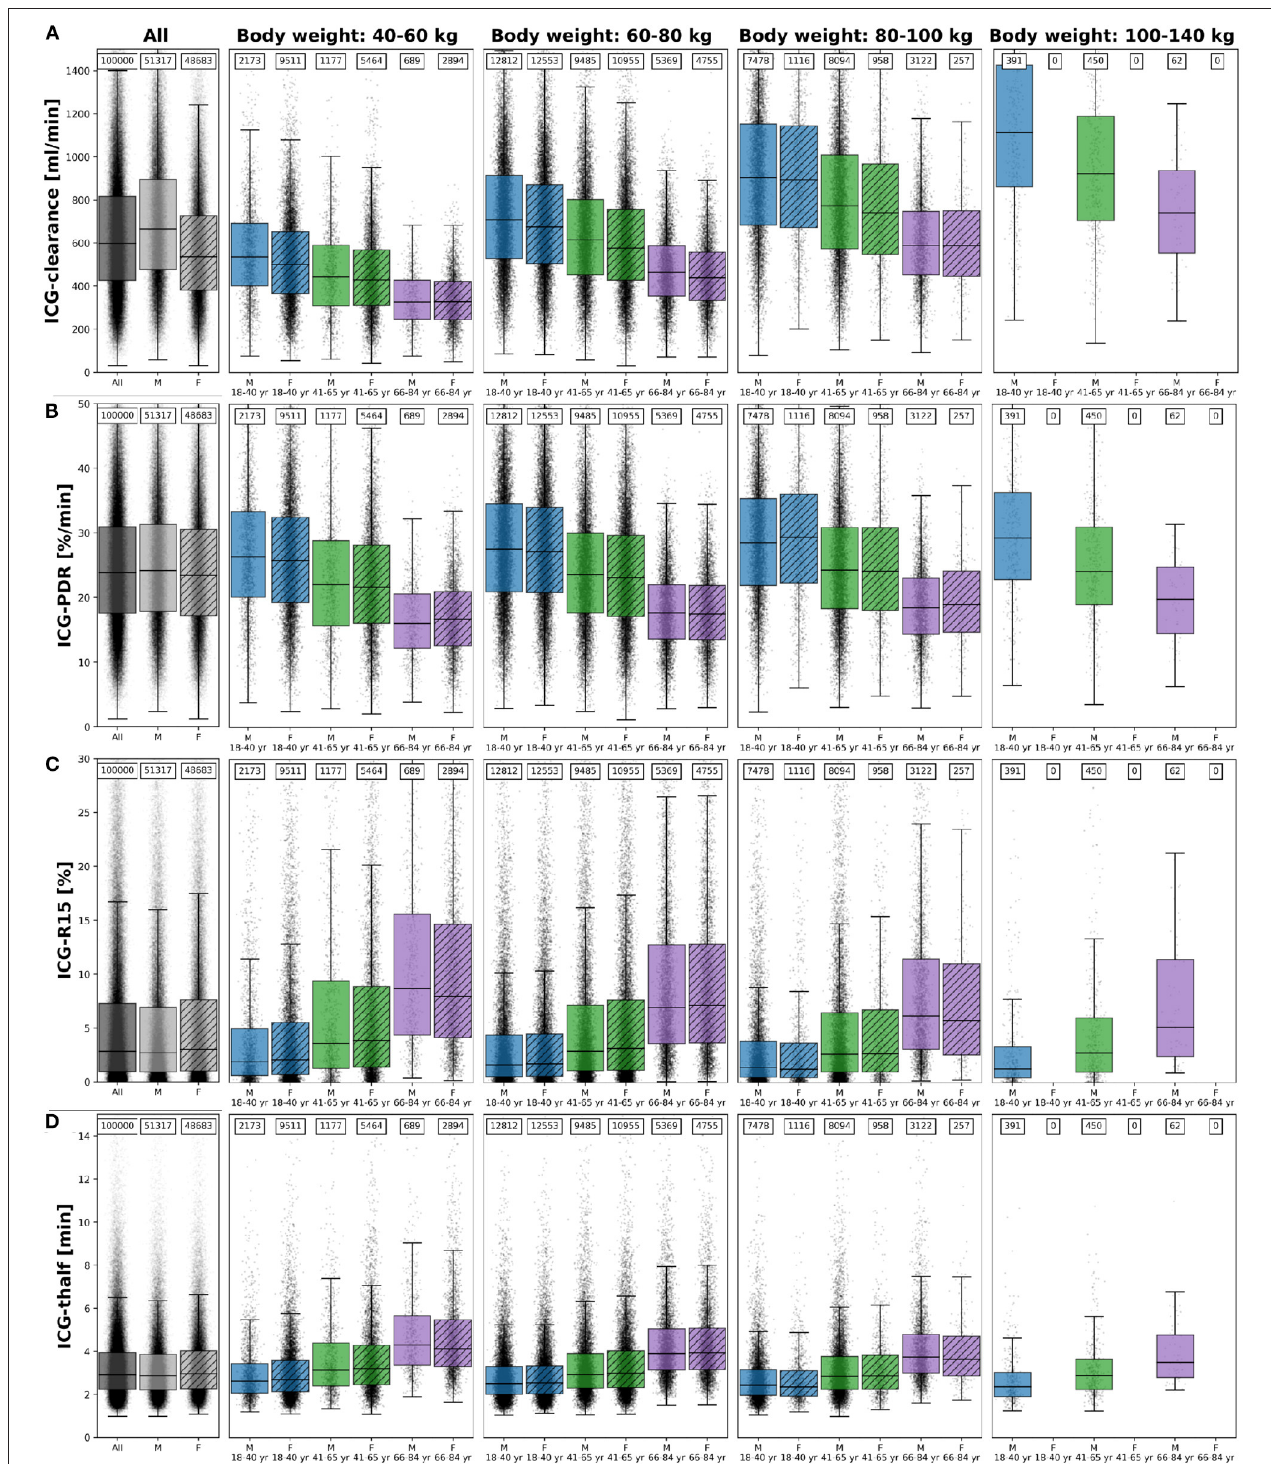
FIGURE 6 | ICG parameters healthy in silico population: The dependency of (A) ICG-clearance [ml/min], (B) ICG-PDR [%/min], (C) ICG-R15[%], and (D) ICG-t 1 / 2 [min] on body weight, sex and age in n = 100,000 individuals. Results are stratified by body weight class (40–60 kg, 60–80 kg, 80–100 kg, and 100–140 kg), age group (blue, 18–40 year; green, 41–65 year; purple, 66–84 year) and sex (M, unshaded; F, shaded). No women exist with body weight > 100 kg in the cohort. The sample size of the respective subgroups are depicted above each boxplot. The box extends from the lower to upper quartile values of the data, with a line at the median with whiskers as defined by Tukey. Individual data points are plotted for all subgroups. Subjects were simulated as healthy controls. For the corresponding results in mild cirrhosis, moderate cirrhosis, and severe cirrhosis see Supplementary Figures 1–3 , respectively.